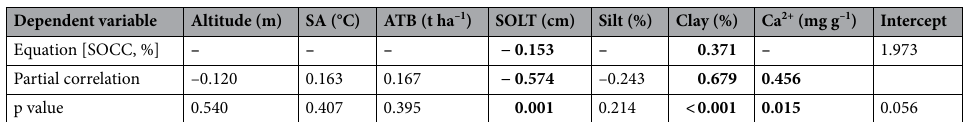
Table 3. Stepwise backward selection multiple linear regression of soil organic carbon concentration (SOCC) on biophysical variables: adj. R 2 = 0.676, p < 0.001. SA slope angle, ATB aboveground tree biomass, SOLT surface organic layer thickness. Numerical values printed in bold are statistically significant (p < 0.05).